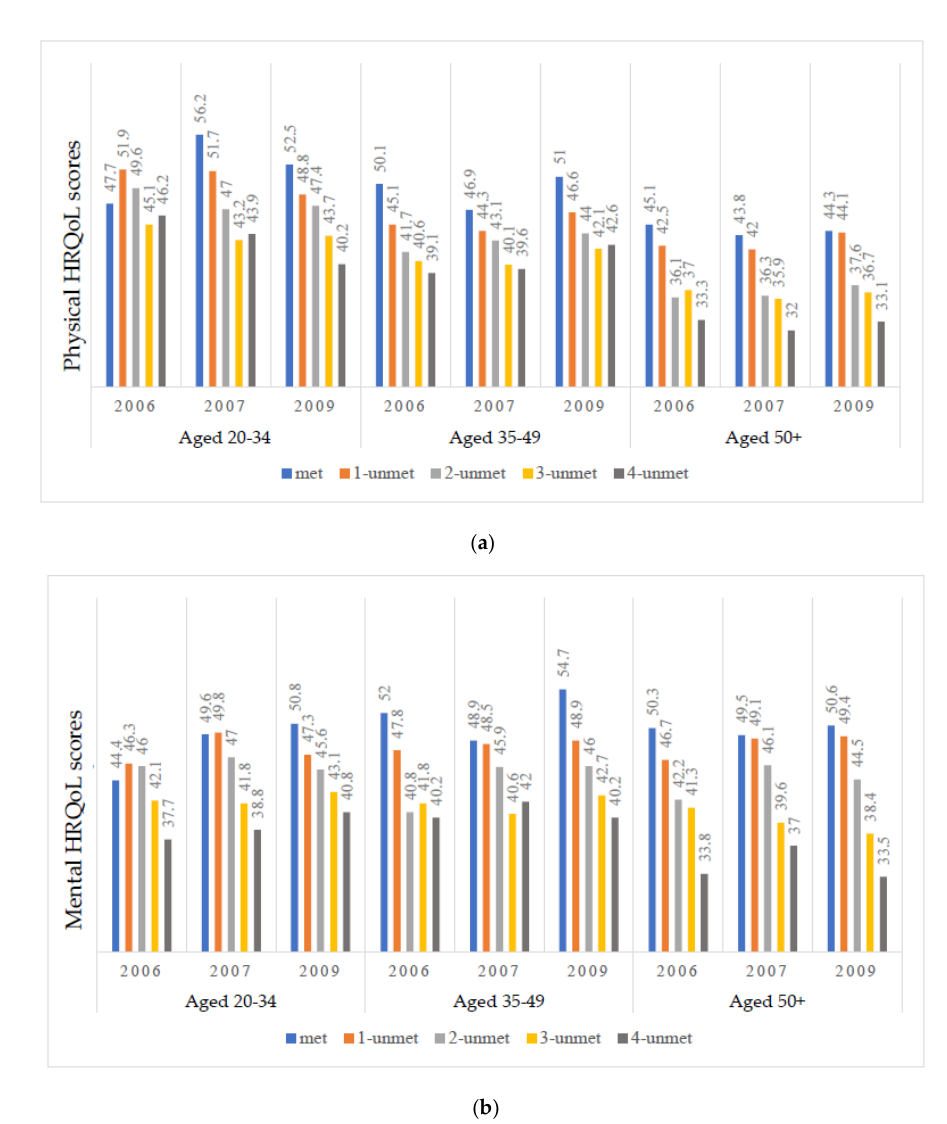
Figure 2. Unadjusted unmet basic needs on physical ( a ) and mental ( b ) HRQoL by age group at each time point in Positive Spaces, Healthy